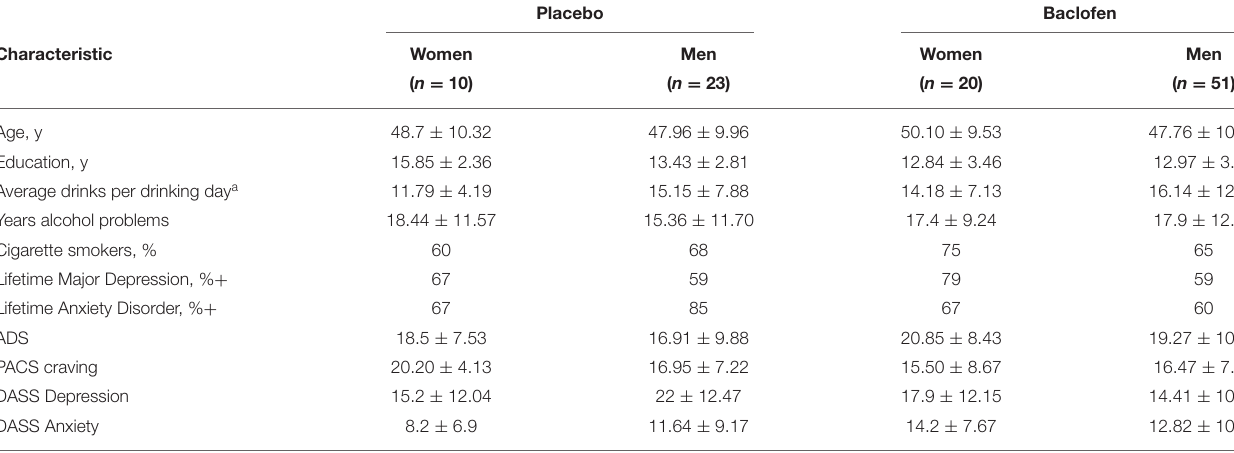
TABLE 2 | Intention to treat: drinking outcome measures at week 12 for women and men treated with either baclofen (30–75mg) or placebo. Outcome Placebo Baclofen Women